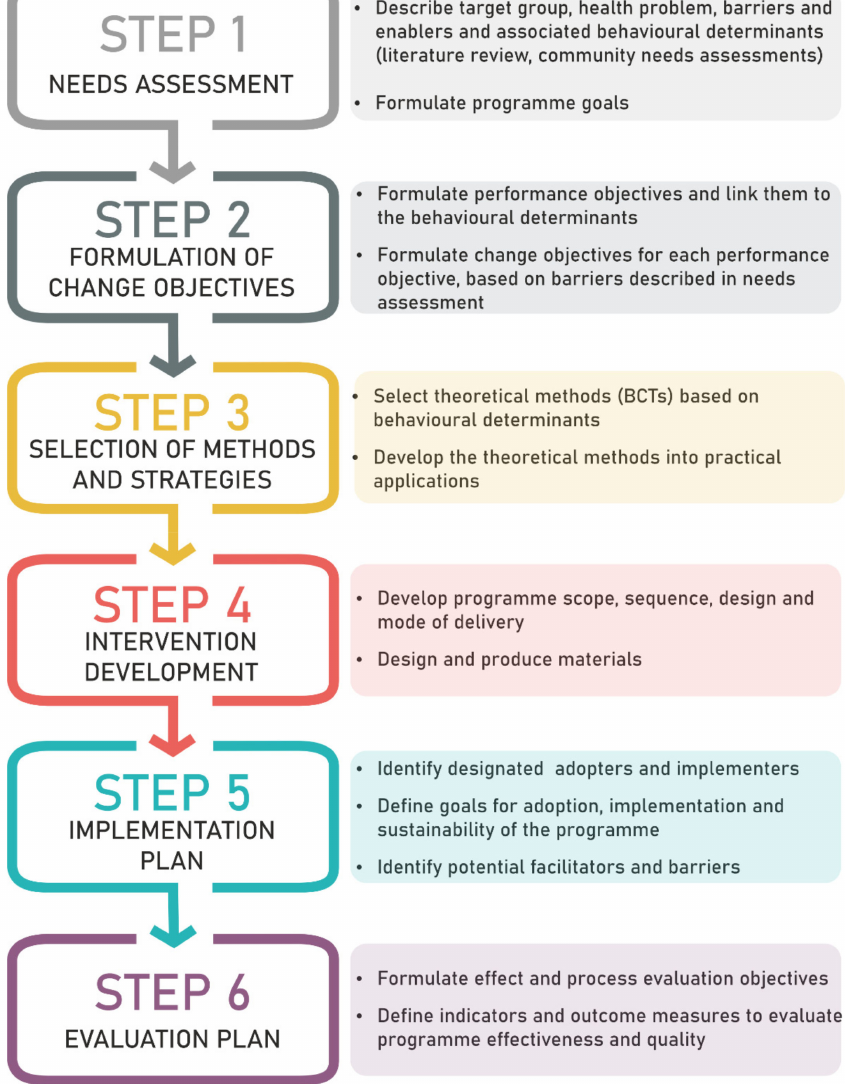
Figure 1. Summary of the six Intervention Mapping steps. BCTs: behavior change